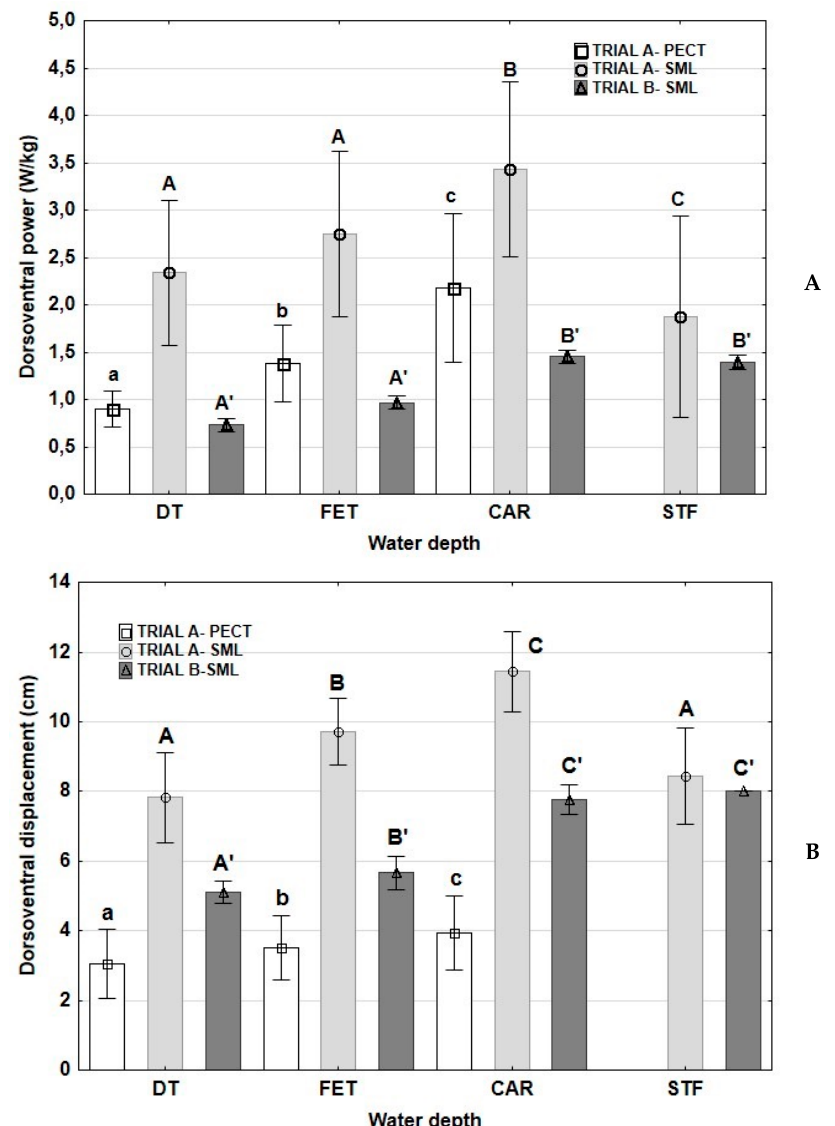
Figure 2. Means and standard deviations (whiskers) of dorsoventral power ( A ) and dorsoventral displacement ( B ) in horses exercised on a water treadmill at different water depths and velocities. DT: dry treadmill, without water; FET: water at the level of the fetlock; CAR: water at the level of the CAR; STF: water at the level of the stifle. Trial A-PECT: accelerometer fixed in the pectoral region with velocities of 6 km/h; Trial A-SML: accelerometer fixed in the sacrum midline at velocities of 6 km/h with the water at DT, FET and CAR and at a velocity of 5 km/h with the water at STF; Trial B-SML: accelerometer fixed in the sacrum midline at a velocity of 5 km/h in the four water depths. Lowercase letters: significant differences between water depths in trial A-PECT; capital letters: significant differences between water depths in trial A-SML; capital letters with apostrophes: significant differences between water depths in trial B-SML. Different letters indicate significant differences between water depths at each trial p < 0.05.